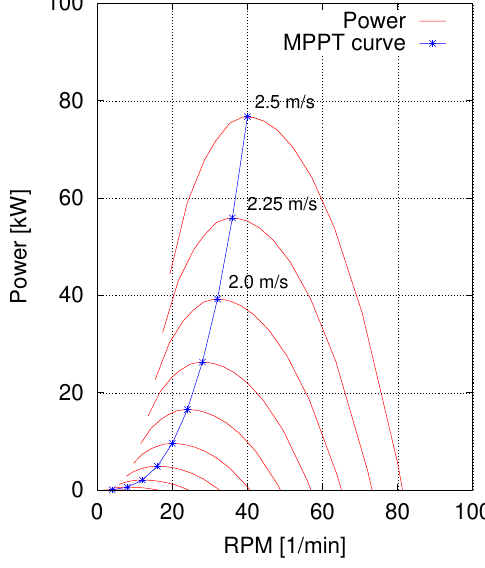
speed) and rated-power condition at V des = 2 . 5 m/s. The maximum mechanical power output is 76.7 kW.